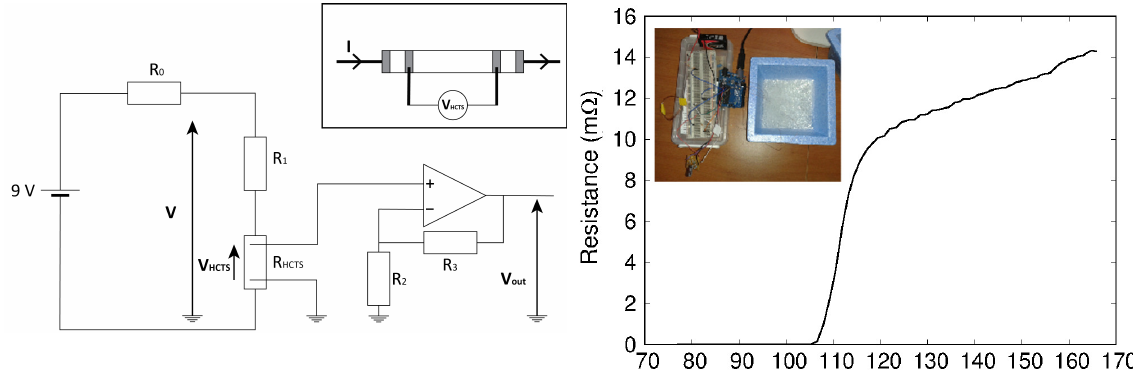
Figure 6: Amplification of the voltage drop across a superconducting sample. Inset: geometry of the HCTS sample.